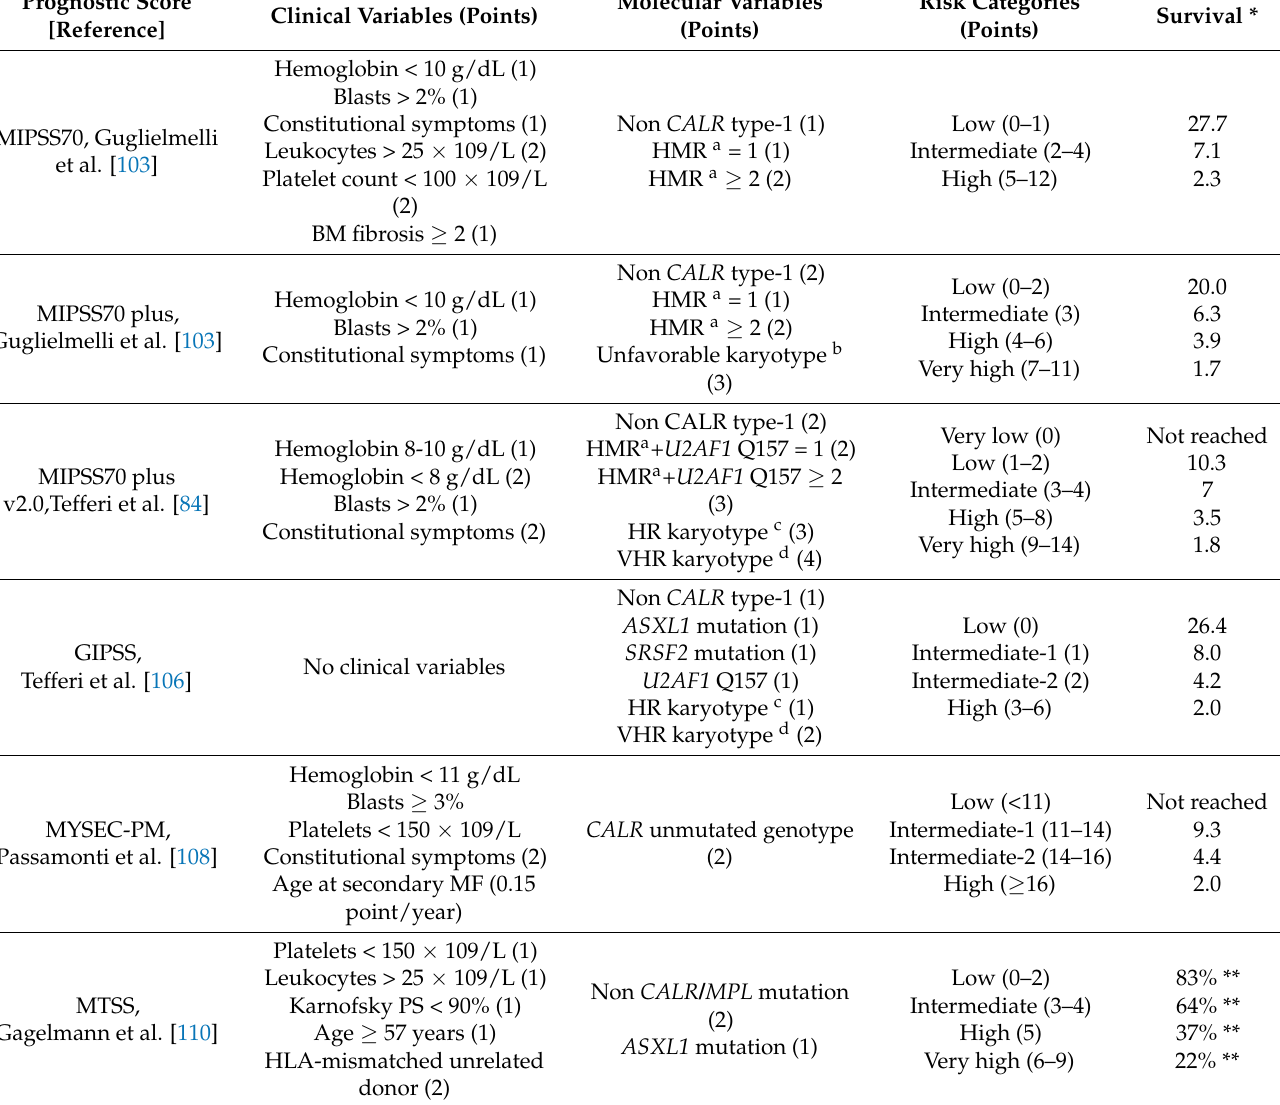
Table 4. Clinical and molecular integrated prognostic scores in